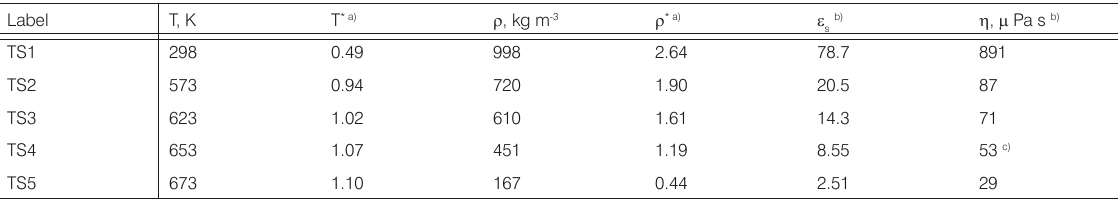
Table 1. The macroscopic properties of the thermodynamic states of water